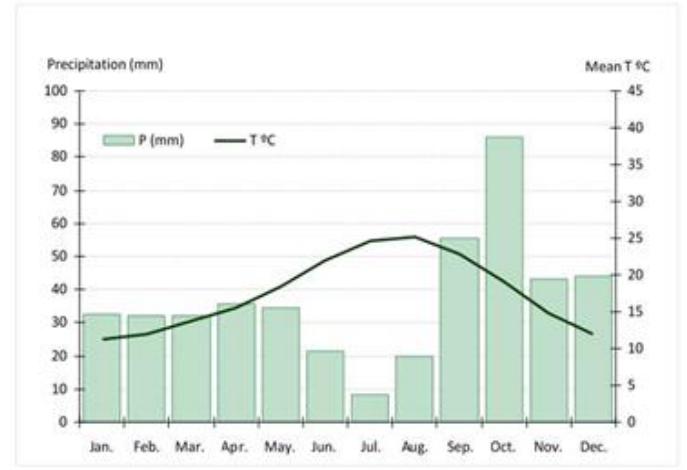
Figure 1. Climograph of the 1938 – 2018 period for Valencia city (Viveros).